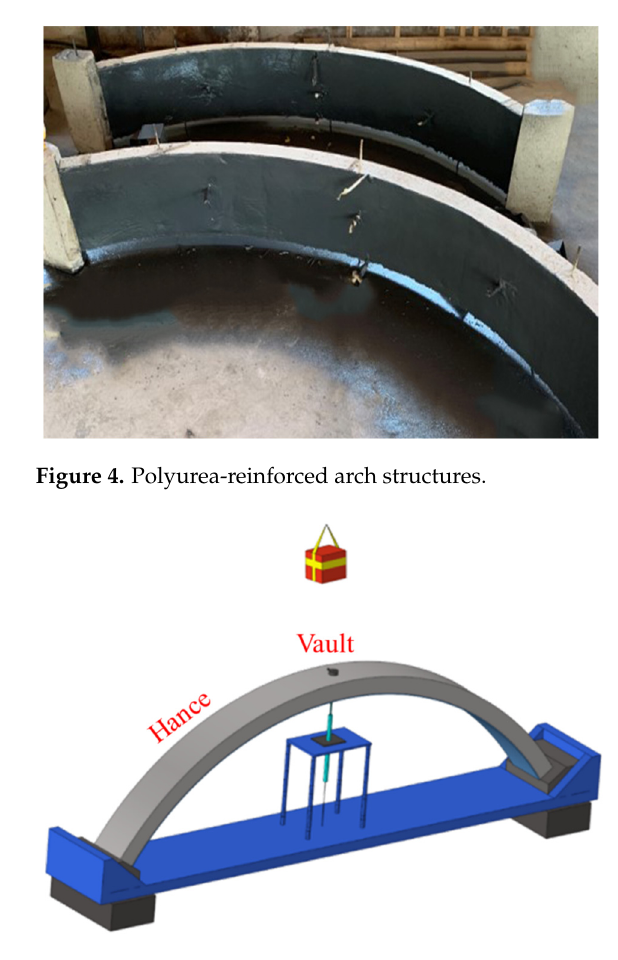
Table 4. Parameters of air and equation of state parameters.